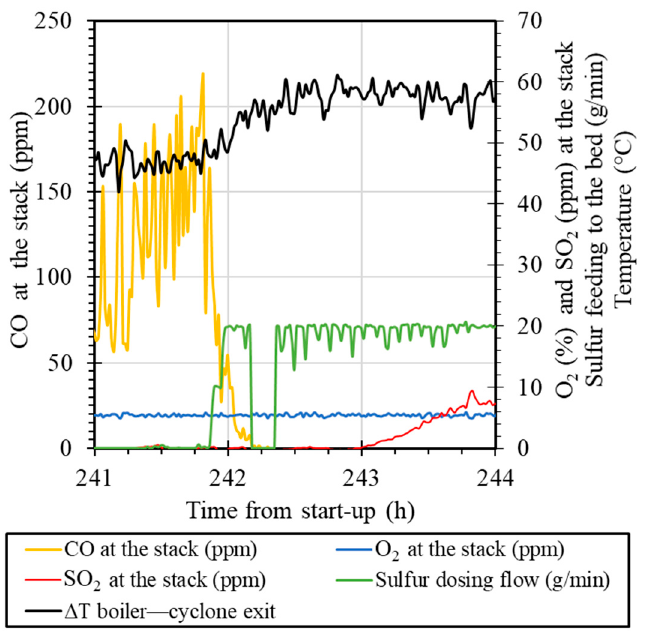
Figure 8. SO 2 and CO concentrations (in ppm) in the chimney vs. the time from start-up.